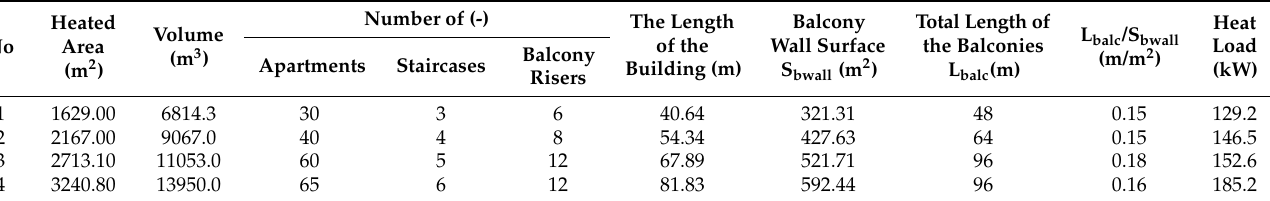
Table 1. The data on analyzed large-panel apartment